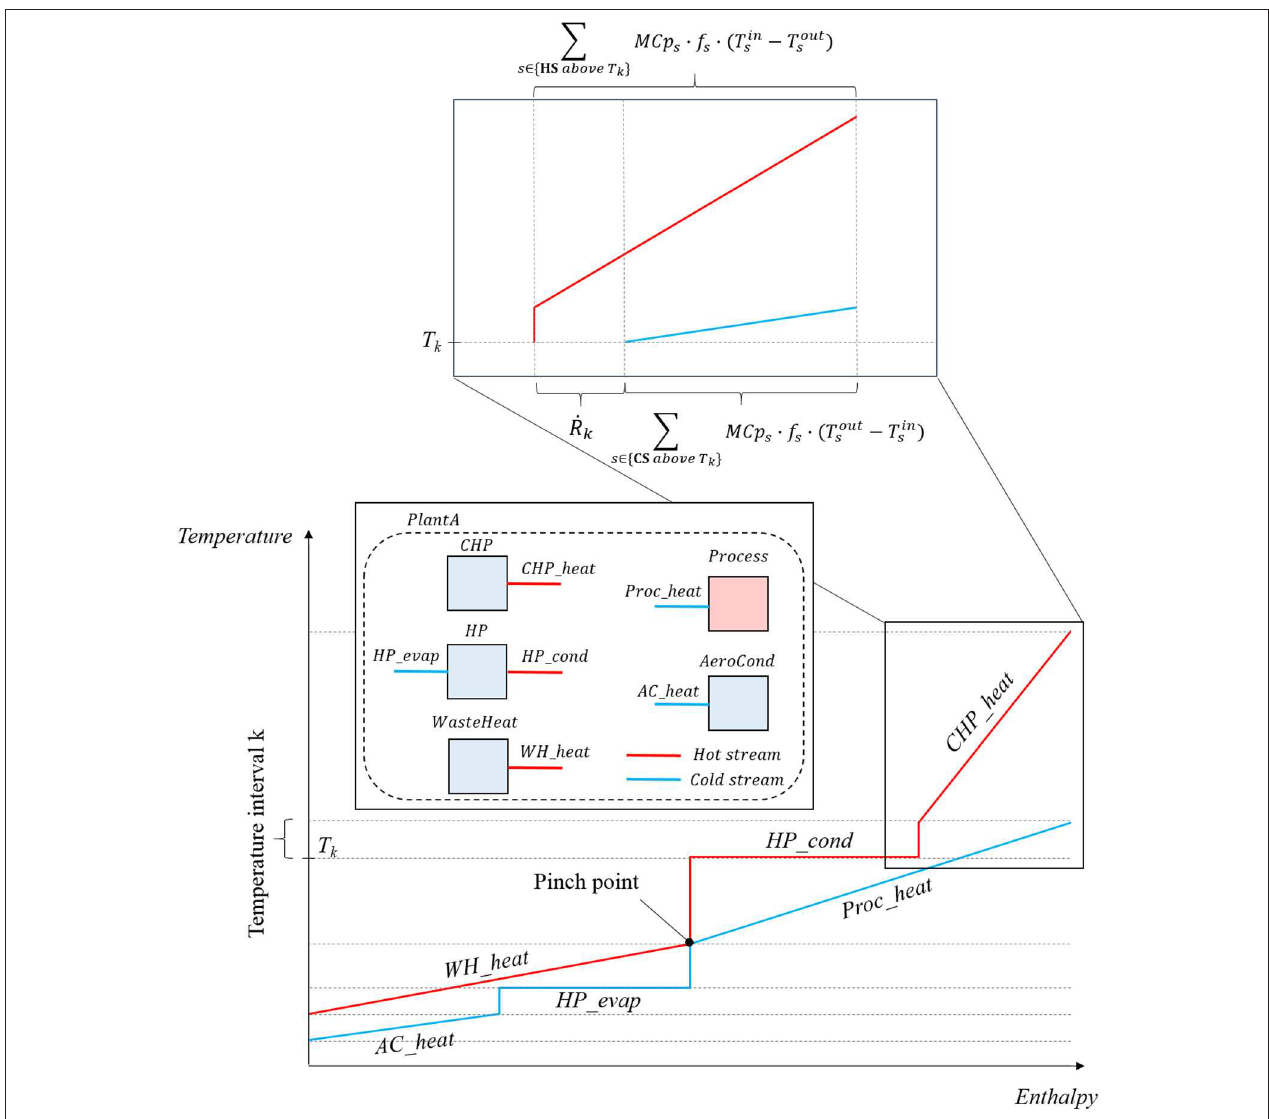
FIGURE 5 | Illustrative example of a heat cascade